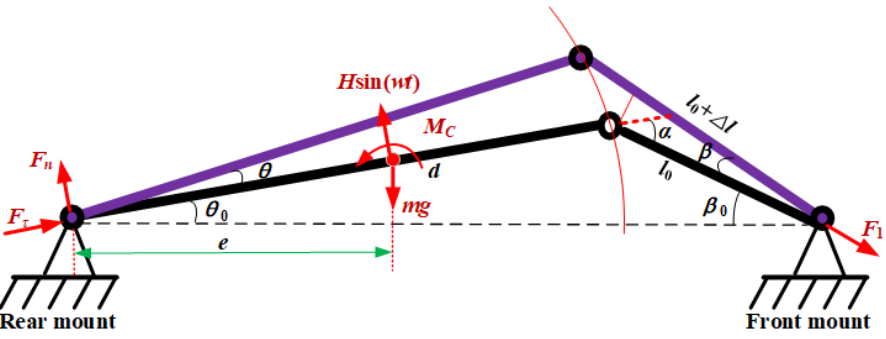
Figure 2. The simplified mechanical model of the oil tank supported by multiple mounting pedes-